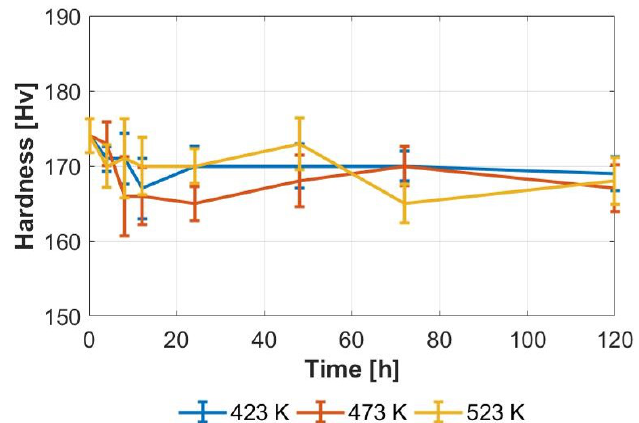
Figure 12. Hardness as a function of prolonged ageing times for three temperatures: 423 K (blue), 473 K (red) and 523 K (yellow). Error bars show one unit of standard